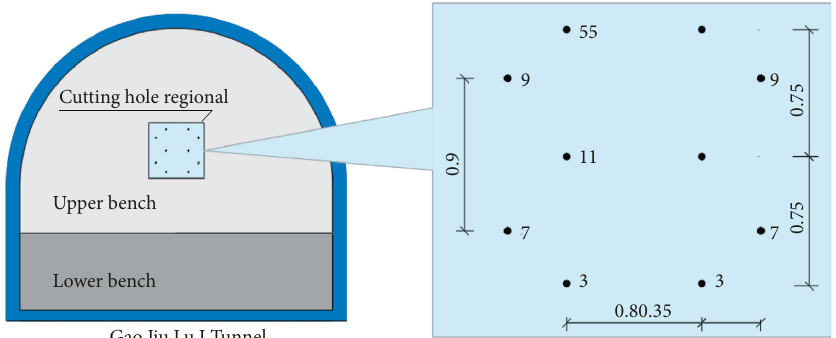
Figure 12: Cutting hole layout (unit: